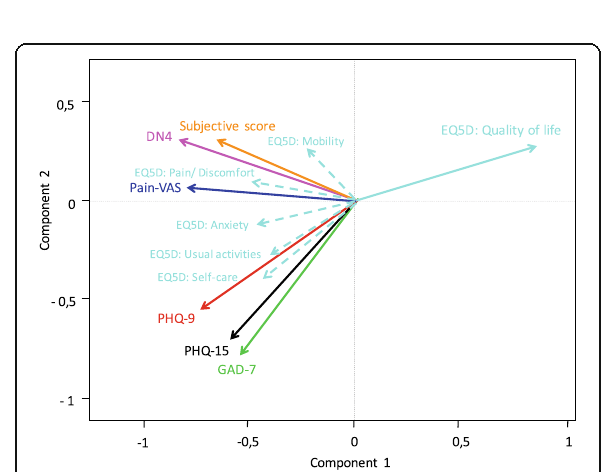
Fig. 4 Biplot of subjective neurosensory measurements. The more similar the direction of two vectors, the stronger the correlation between these variables. A strong positive correlation suggests that the two questionnaires offer virtually the same information. This figure shows a negative correlation between quality of life and all other questionnaires. There is a strong positive correlation between Pain-VAS, DN4, and subjective score, as well as between PHQ-9, PHQ-15, and GAD-7 scores. Also, concerning the correlation between the individual questions for each questionnaire, those of the EQ5D-5 L scale where the least correlated with one